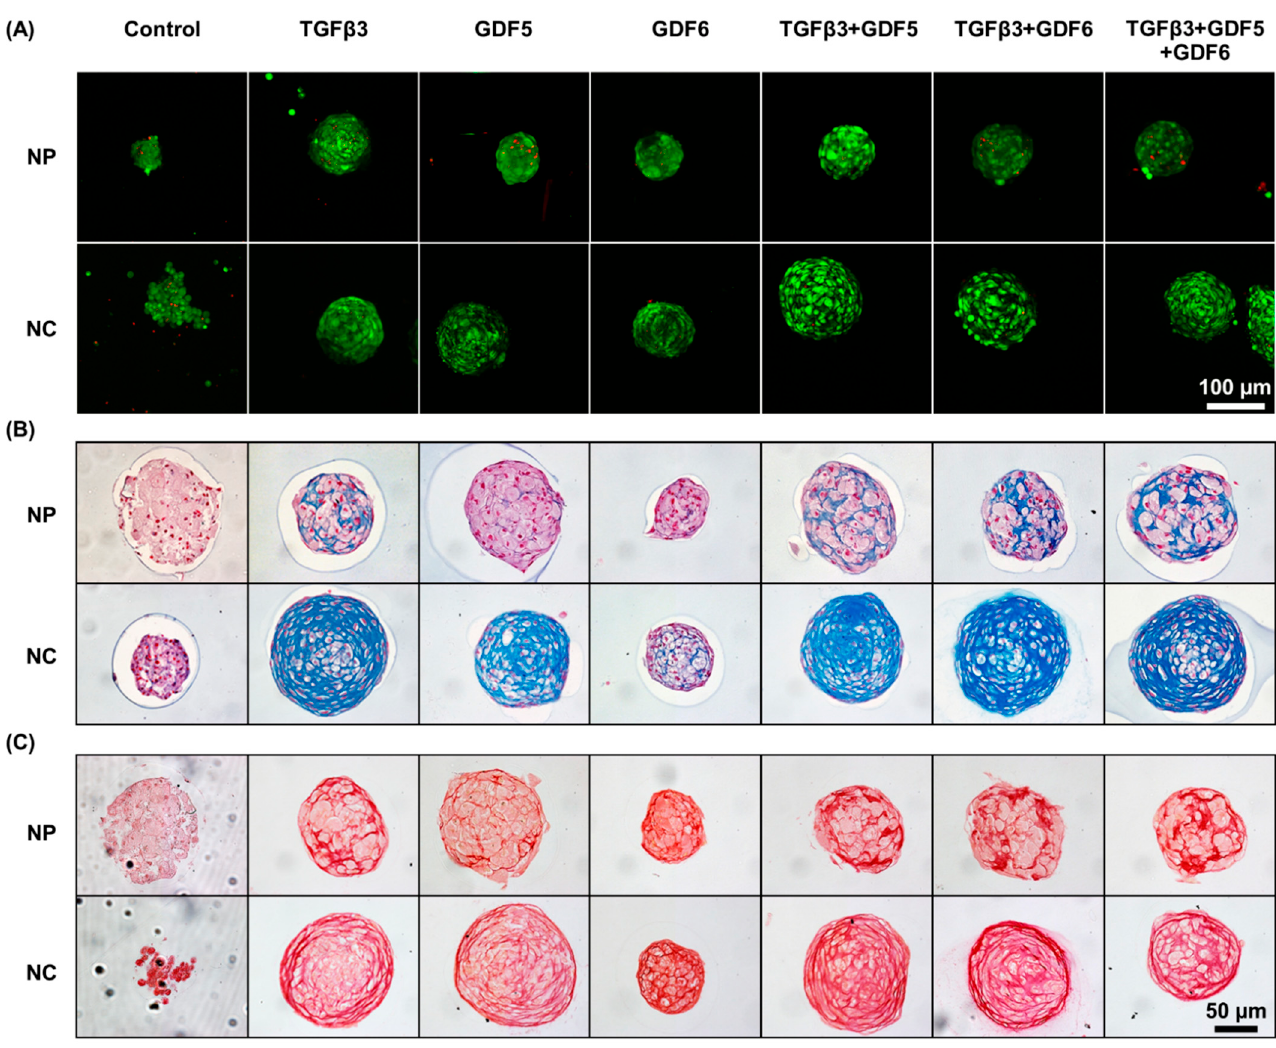
Figure 5. Live/Dead ® and histological staining of nucleus pulposus (NP) and nasoseptal chondrocyte (NC) microtissues (1000 cells/microtissue) treated with no growth factor (control) or stimulated with TGF β 3, GDF5, GDF6, TGF β 3 + GDF5, TGF β 3 + GDF6, TGF β 3 + GDF5 + GDF6 on day 7. ( A ) Live/Dead ® fluorescent images demonstrating cell viability. Histological evaluation with ( B ) alcian blue staining to identify sGAG and ( C ) picrosirius red to detect collagen.